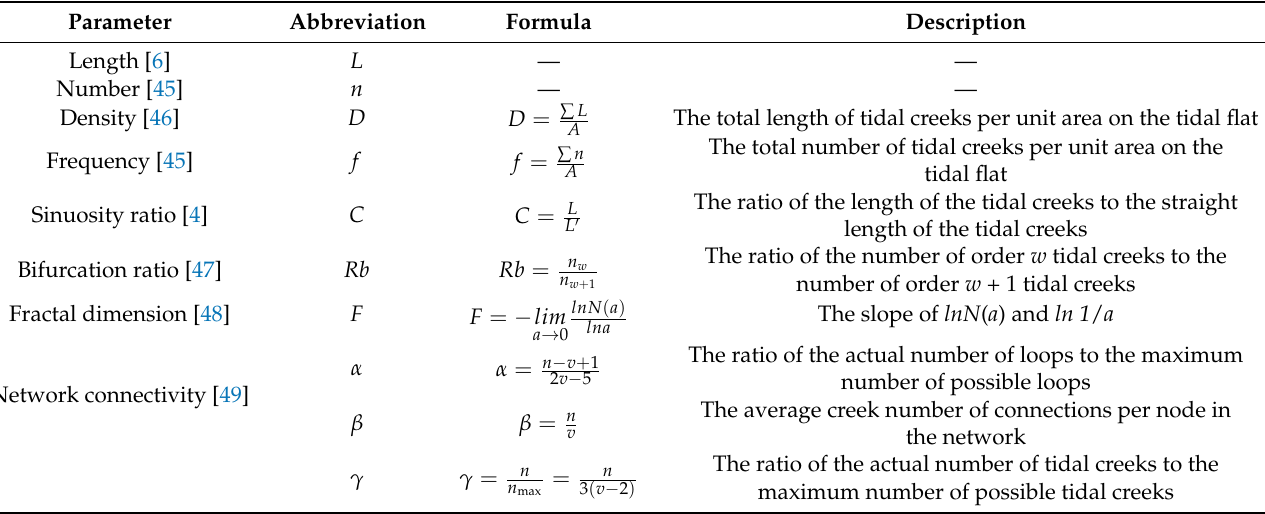
Table 2. Morphological parameters of tidal creeks in the LRE and the formulas for calculating the